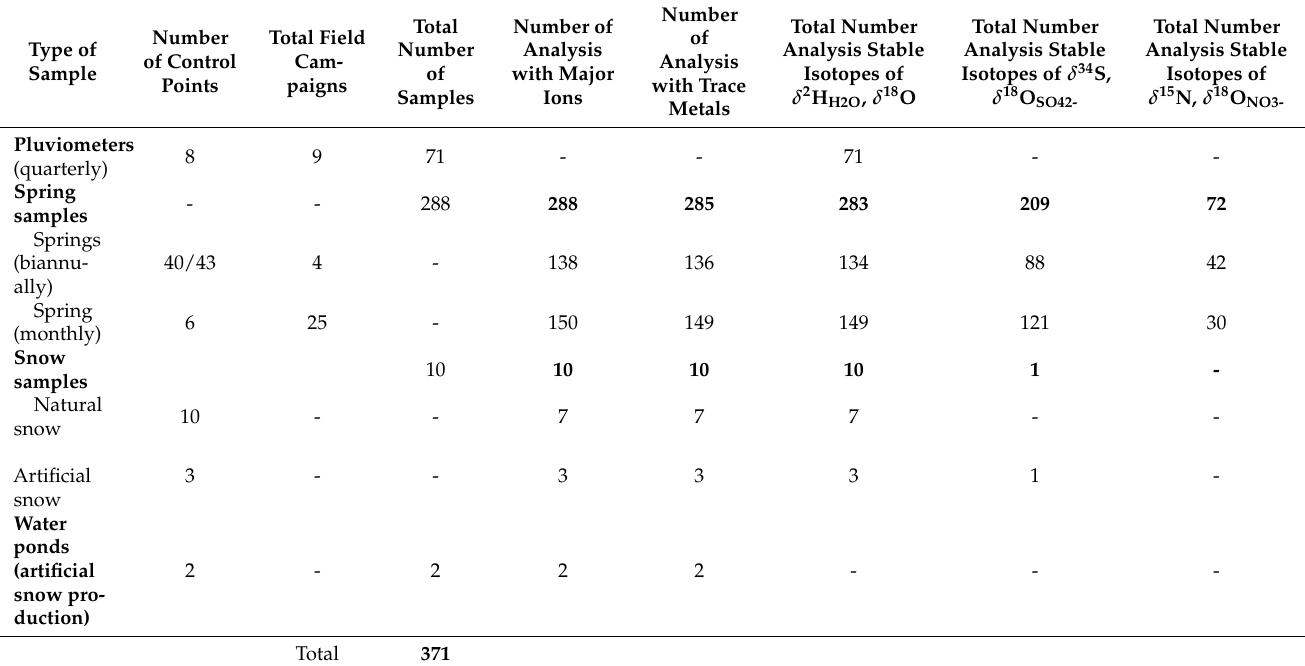
Table A1. Summary of water sample types and analysis done in the research project.